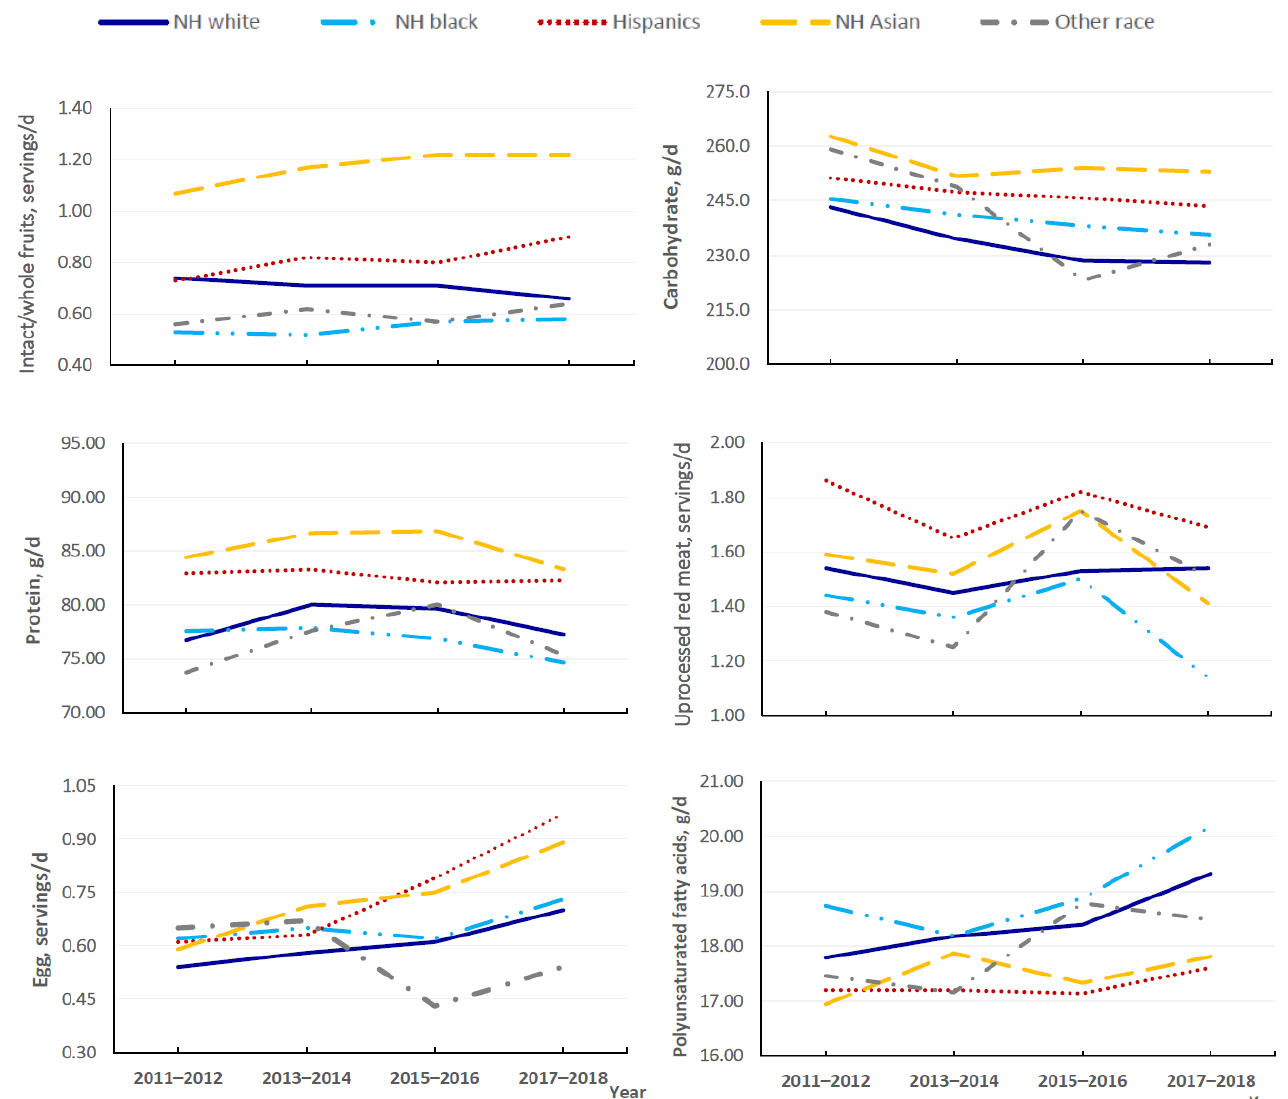
Figure 3. Trends in estimated mean daily consumption of selected food groups and nutrients by race/ethnicity among US adults aged ≥20 years for 2011 – 2018.